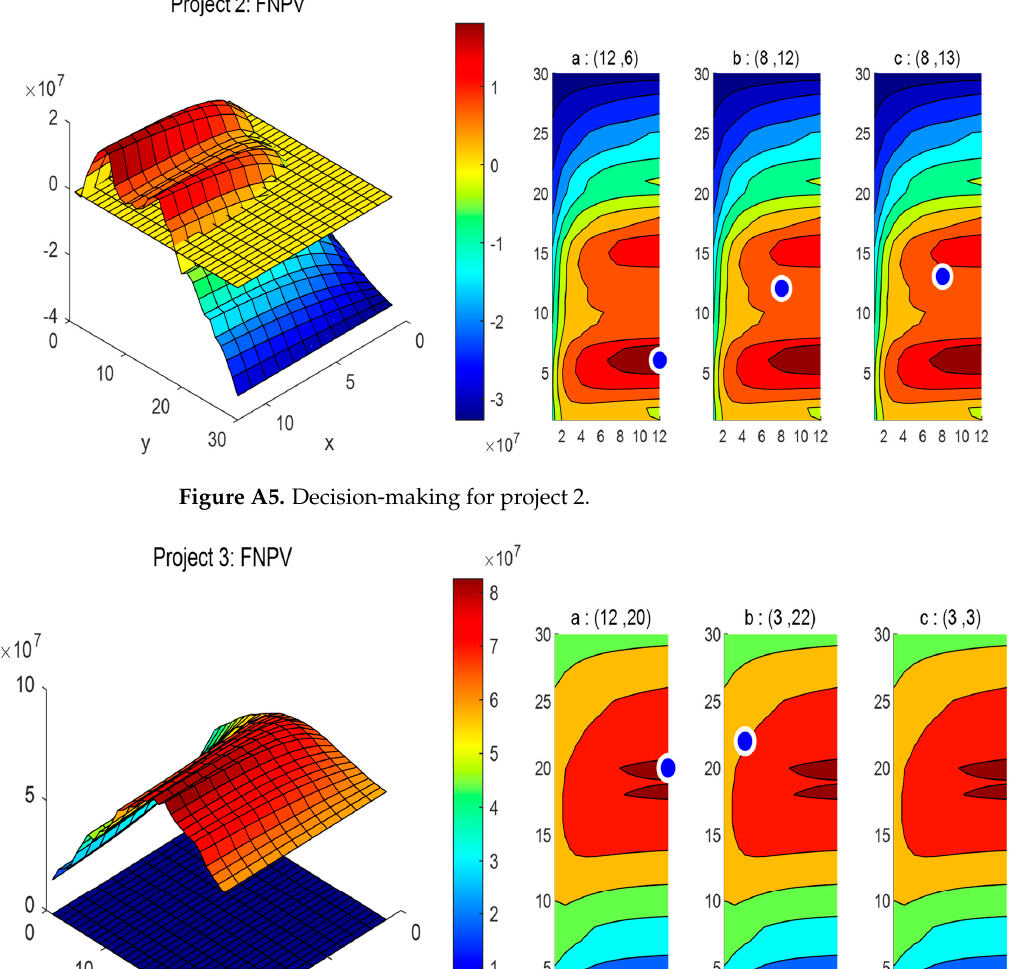
Figure A4. Decision − making for project 1.